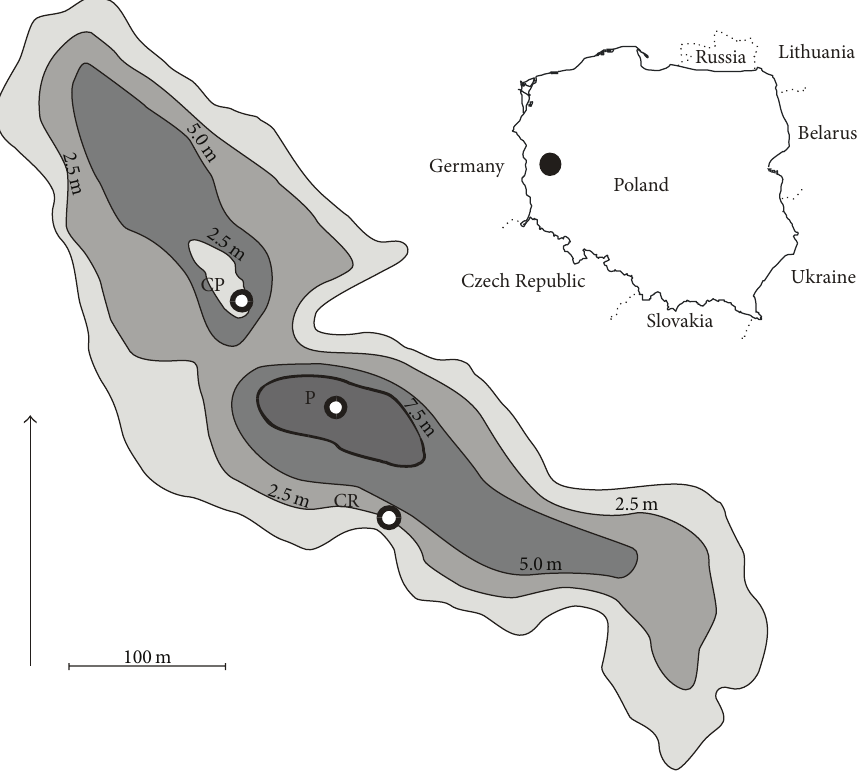
Figure 1: Location of Lake Jasne (mid-western Poland) and distribution of the sampling sites: P: pelagial, CP: C. polyacantha , and CR: C. rudis .